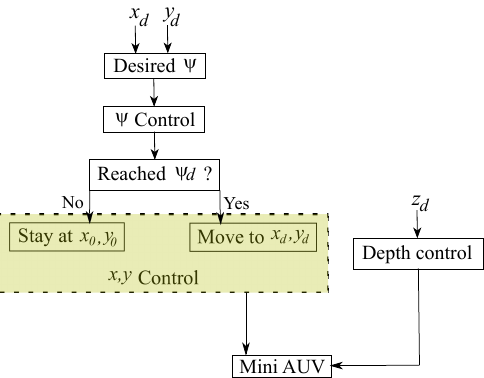
Figure 13. Control strategy for the mini-AUV.